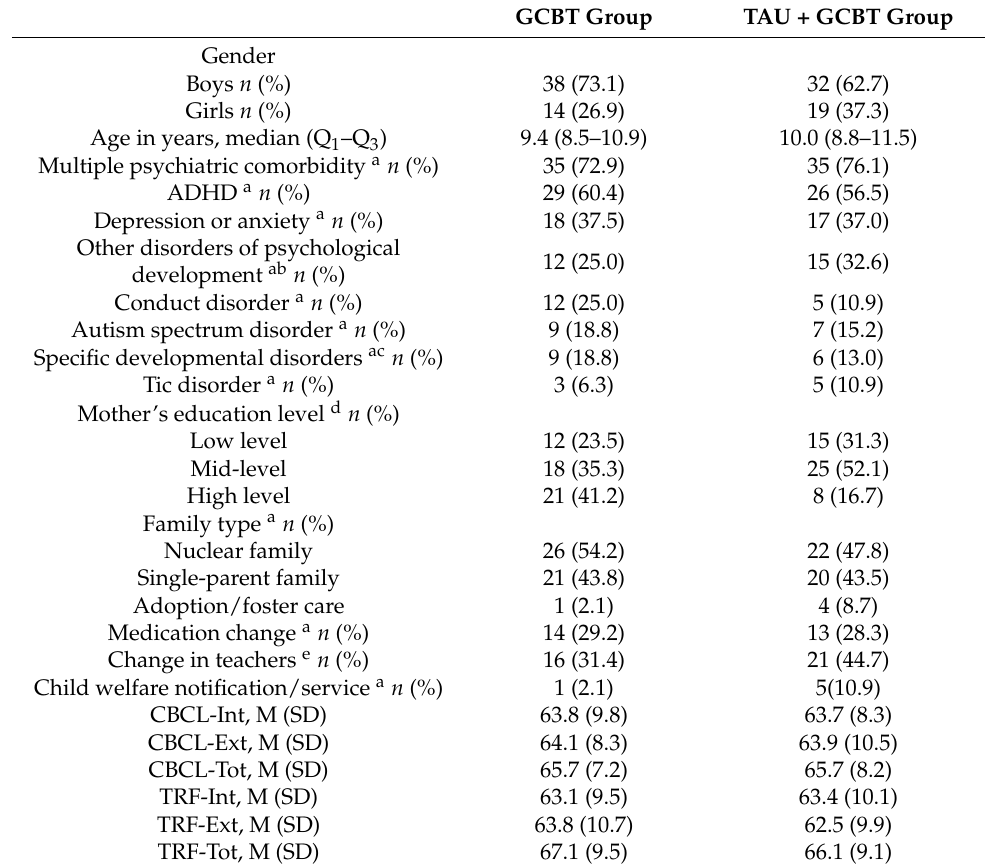
Table 1. Demographic data for the GCBT ( n = 52) and TAU + GCBT group ( n = 51) at